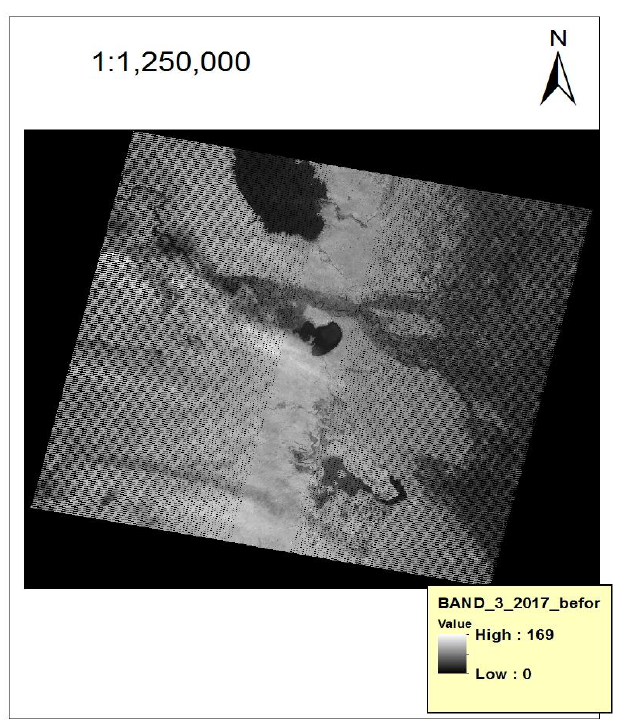
Fig.9: Show image of band (4) in date (27/11/2017).